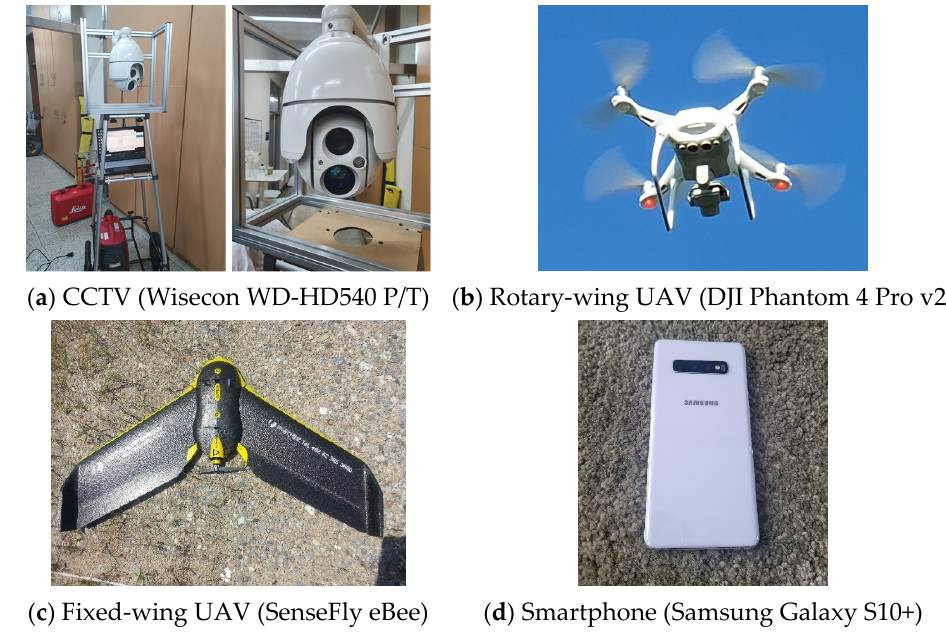
Figure 3. Camera sensor platforms.